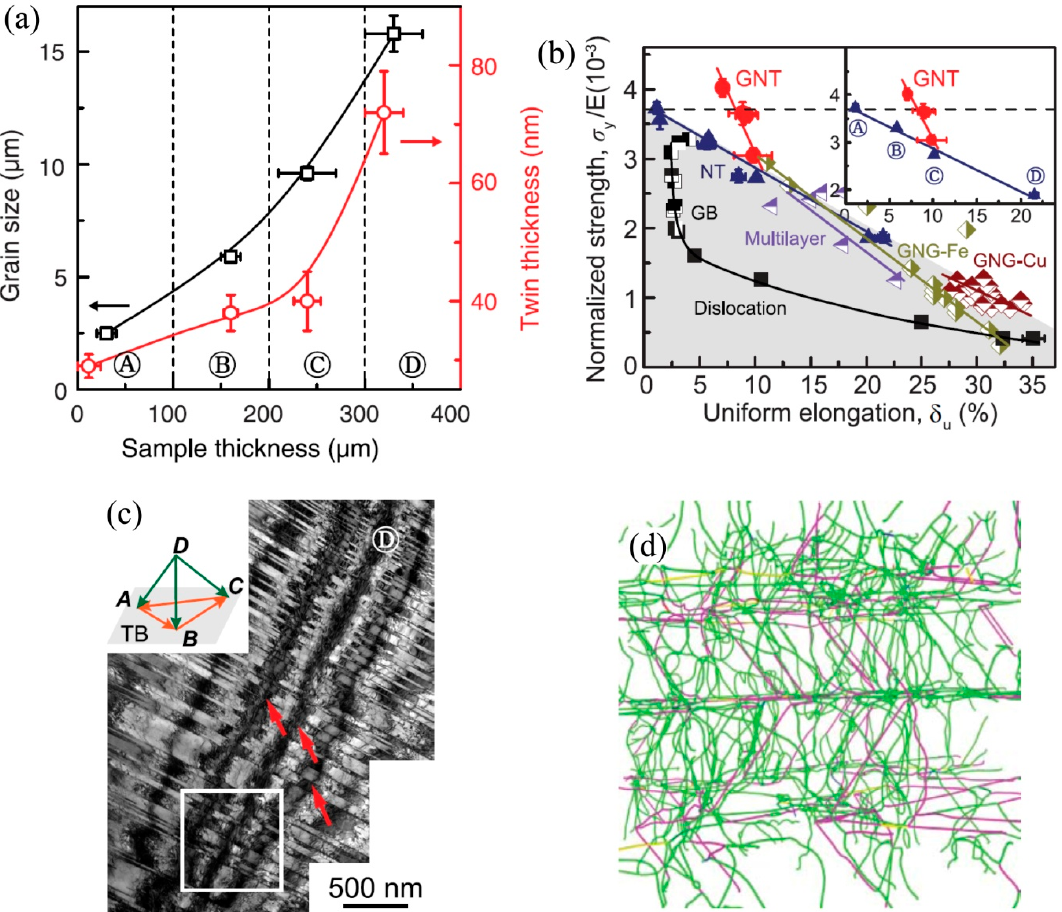
Figure 8. Tensile properties and corresponding deformation mechanisms of gradient nanotwinned copper with highly tunable structural gradients: ( a ) Grain size and twin thickness distributions along the thickness; ( b ) Tensile properties; ( c ) Deformation microstructure of gradient nanotwinned structure at 1% strain showing bundles of concentrated dislocations; ( d ) High density of dislocations in the bundles of concentrated dislocations revealed by MD. Adapted from [13].